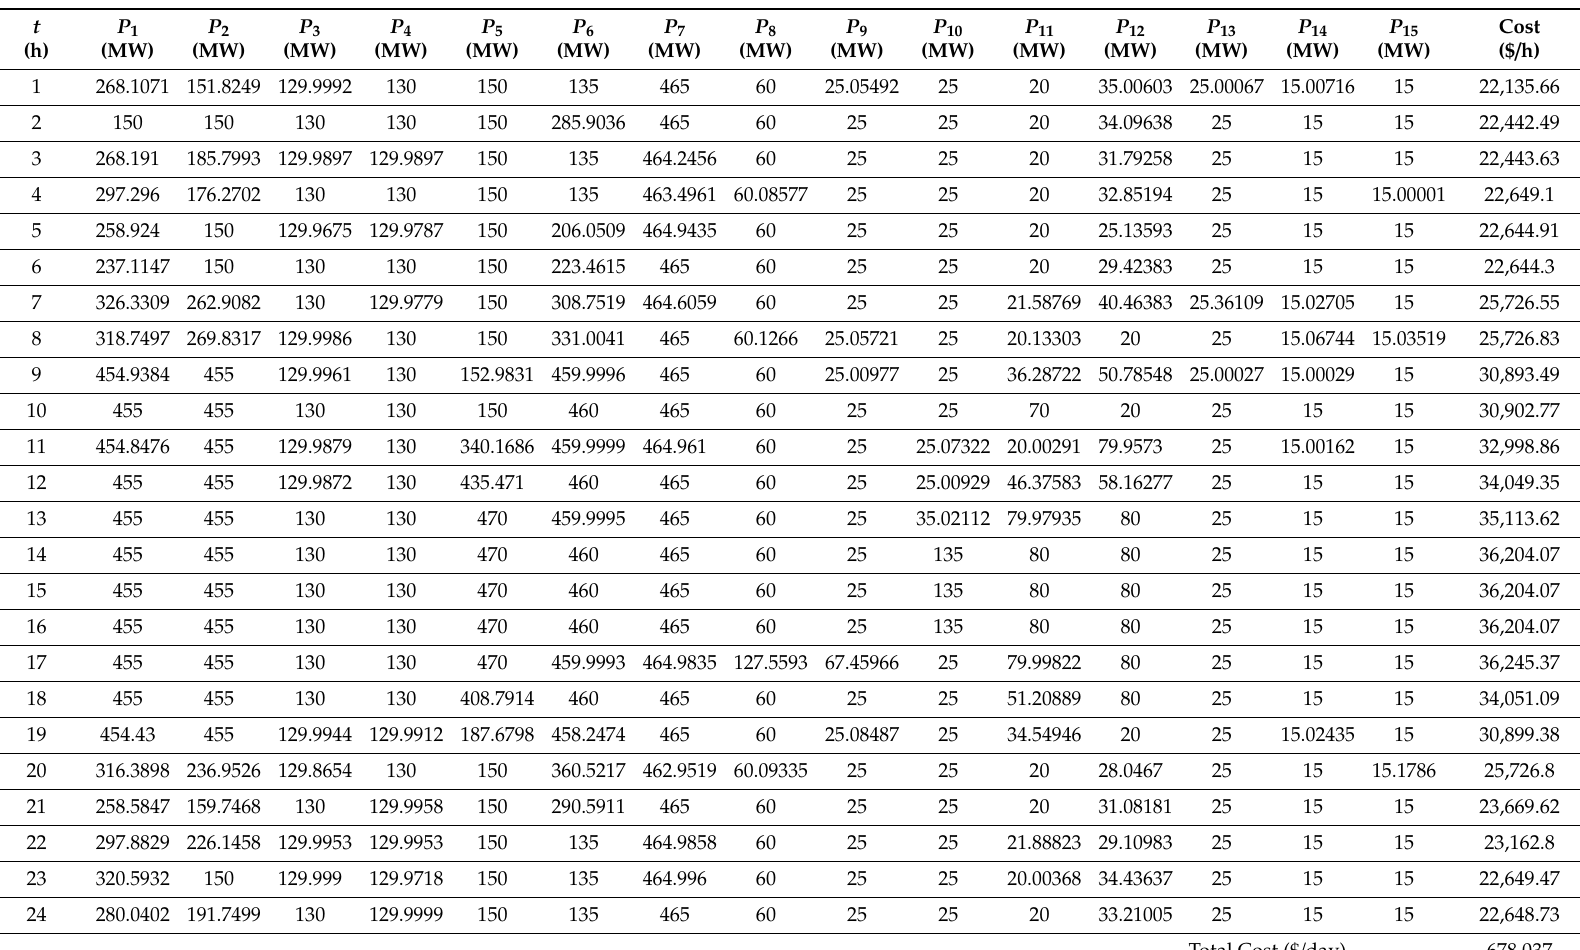
Table 10. The dBA on a 15-unit system without